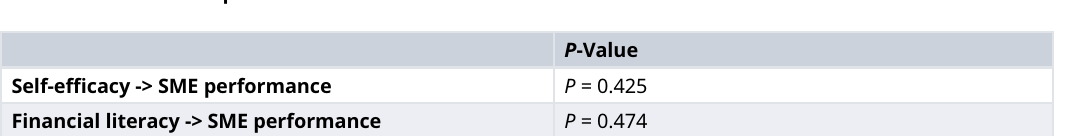
Table 2. Results of the path coefficient test.